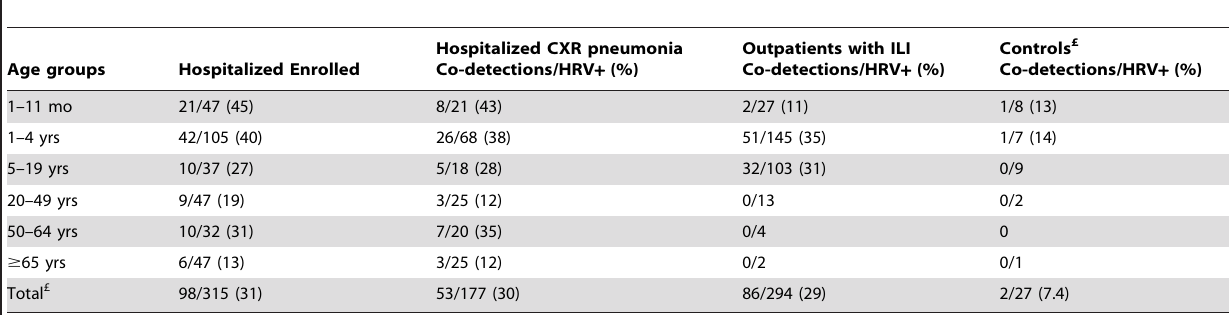
Table 3. Patients with HRV detection and co-detection of other respiratory pathogens*, Sa Kaeo Province, Thailand, September 1, 2003–August 31, 2005.